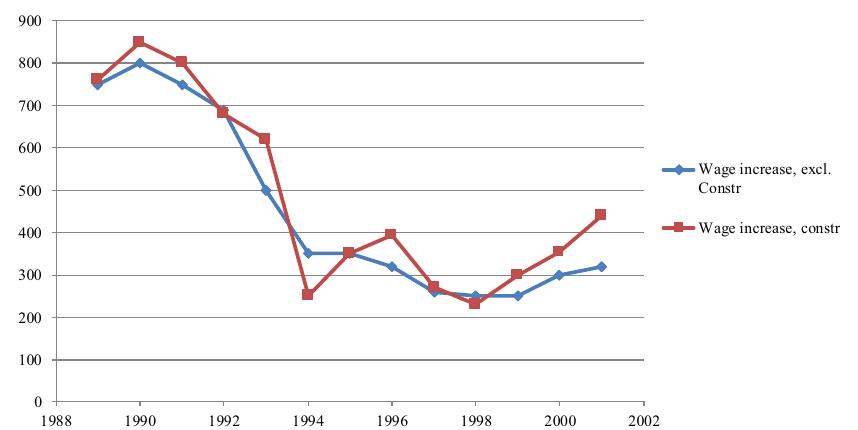
Fig. 5 Bargained nominal wage growth in construction and the rest of industries. Source : Registry of Collective Agreements 1990–2001 we document below, one of the advantages of using such wage floors is that the